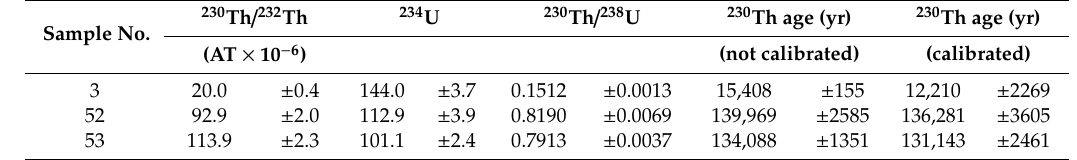
Table 3. Activity ratios used for age calculation and isochron U-Th